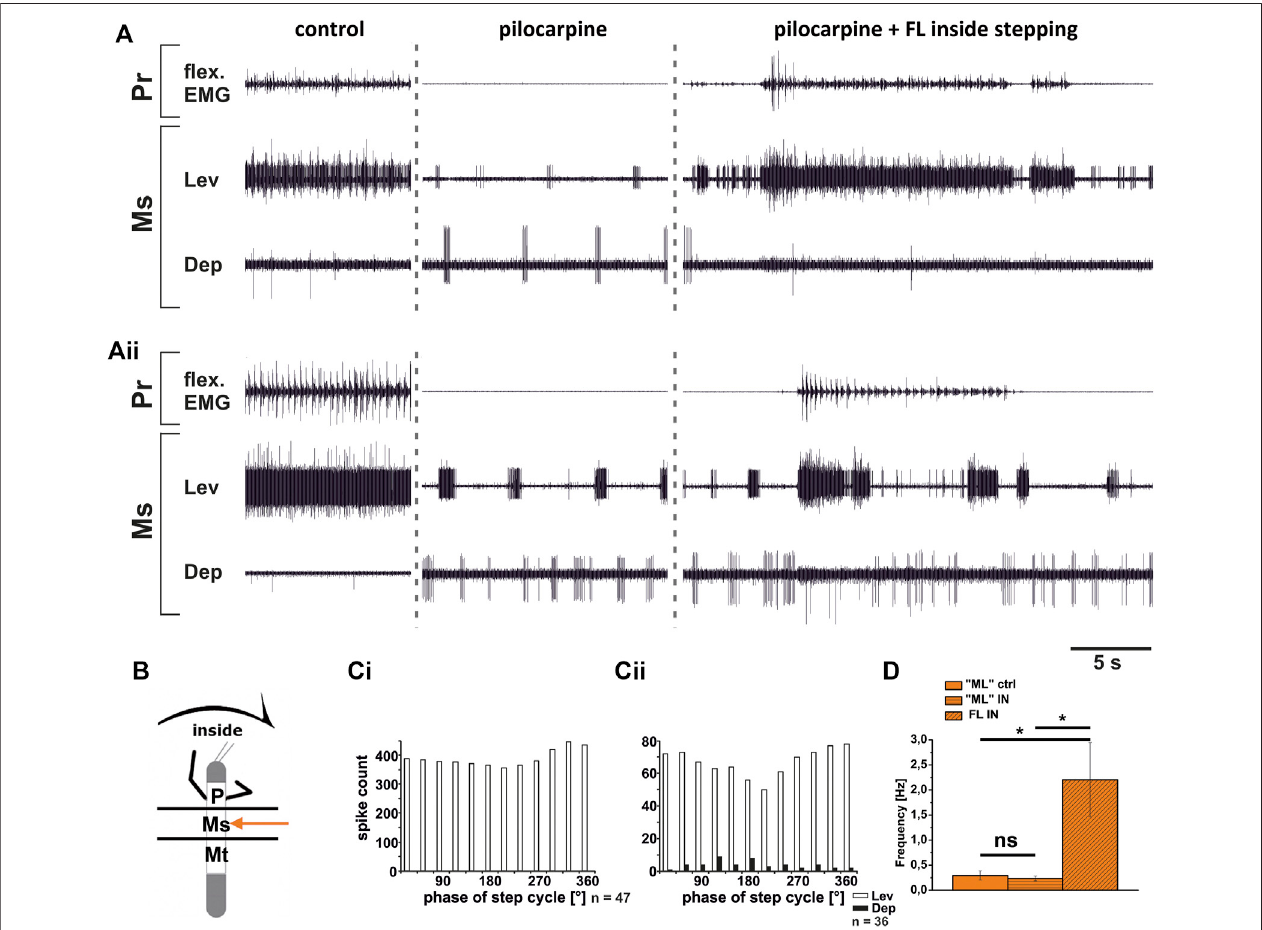
FIGURE 8 | Motor output of levator (Lev) and depressor (Dep) trochanteris MN pools in the pilocarpine activated deafferented mesothoracic ganglion (Ms) during front leg(FL)insidestepping; (Ai,Aii) twoexamplesforFLFlexorEMG( “ fl ex ” ,top),togetherwithextracellularrecordings oftheipsilateralmesothoracic levator(C1nerve, second trace) and depressor (C2 nerve, third trace) nerve during control inside steps, in pilocarpine w/o FL steps, and during inside stepping under pilocarpine application; (B) . Schematic of experimental split-bath con fi guration; (Ci,Cii) Phase histograms of levator and depressor nerve activity under pilocarpine during inside stepping from the animals in (Ai,Aii) , with respect to the FL step cycle; (D) . Comparison of pilocarpine C1 control Burst frequency ( “ ML ” ctrl) with deafferent ML- segmentC1burstfrequency( “ ML ” IN)duringinsidestepsofthefrontlegs(FLIN)from18walkingsequencesinthreeexperiments(signi fi cancelevel < 0.05); n =numberof analyzed steps. Pr: prothoracic/FL segment. ns: not signi fi cant. The sketch indicates a stick insect with front legs in a fl exed (inside) or stretched (outside) position, and the arrow above indicating the turning direction, the arrow on the side the recorded thoracic segment. The black bars symbolize the vaseline